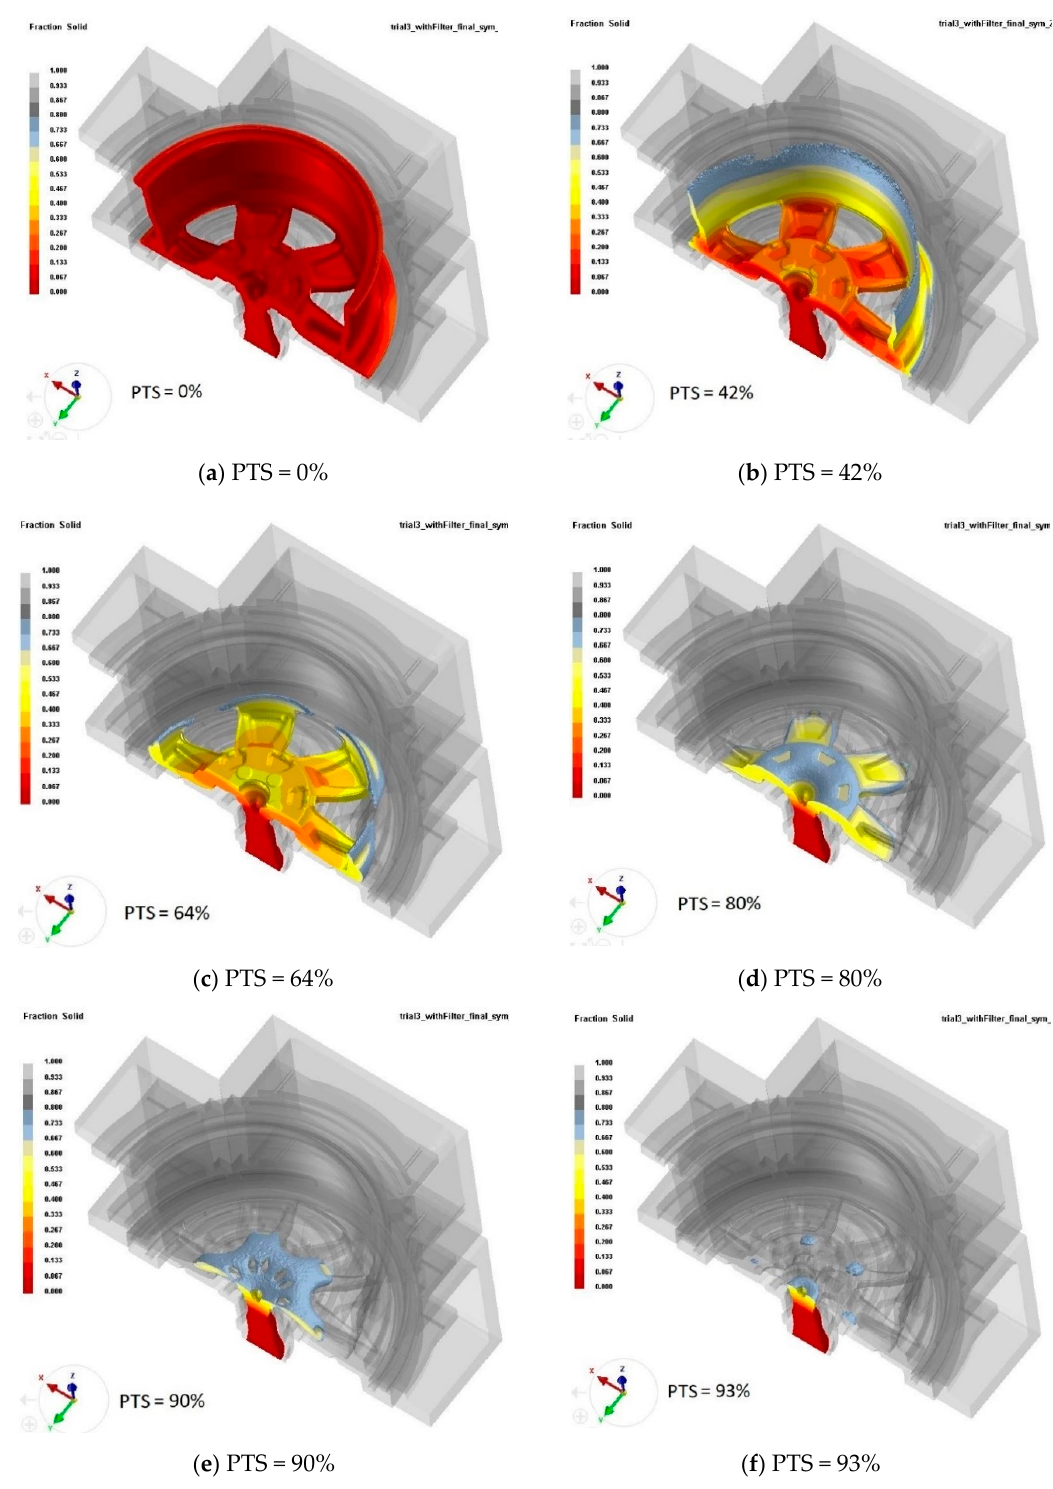
Figure 16. Solidification path for the production process condition.